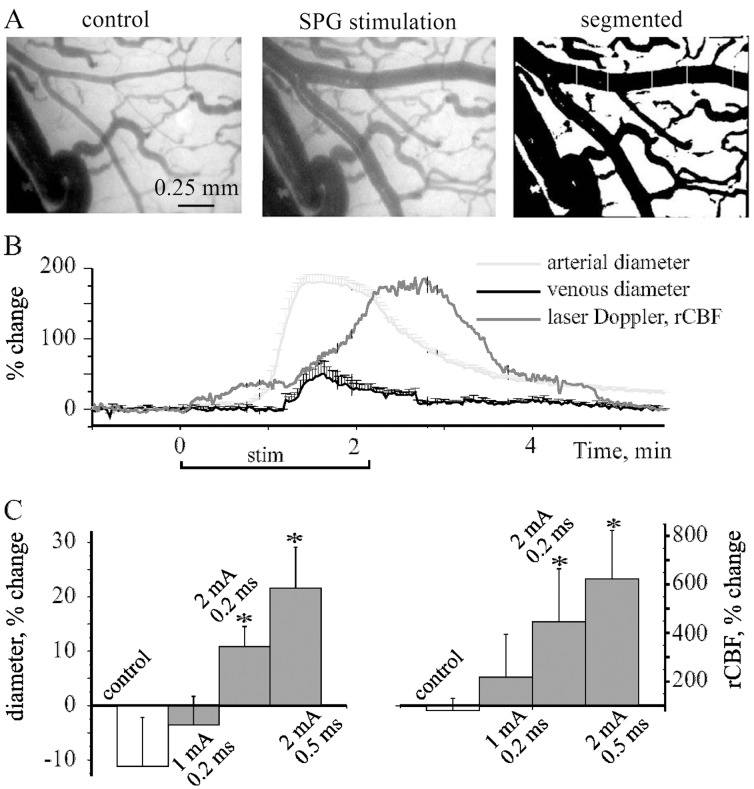
SPG stimulation induces vasodilation in the healthy brain A, Left and middle, respectively, representative image of the brain surface under control conditions and during SPG stimulation: right, the same image after processing for diameter measurement.B, Arterial (red) and venous (blue) changes in diameter (presented as % change from baseline) are shown before, during and after a single stimulation train for the experiment shown in (A). Note that increased rCBF (gray) is following the arterial vasodilation. C, Average % change in arterial diameter (left graph) and rCBF (right graph) during different stimulation protocols (see text). *p<0.05.